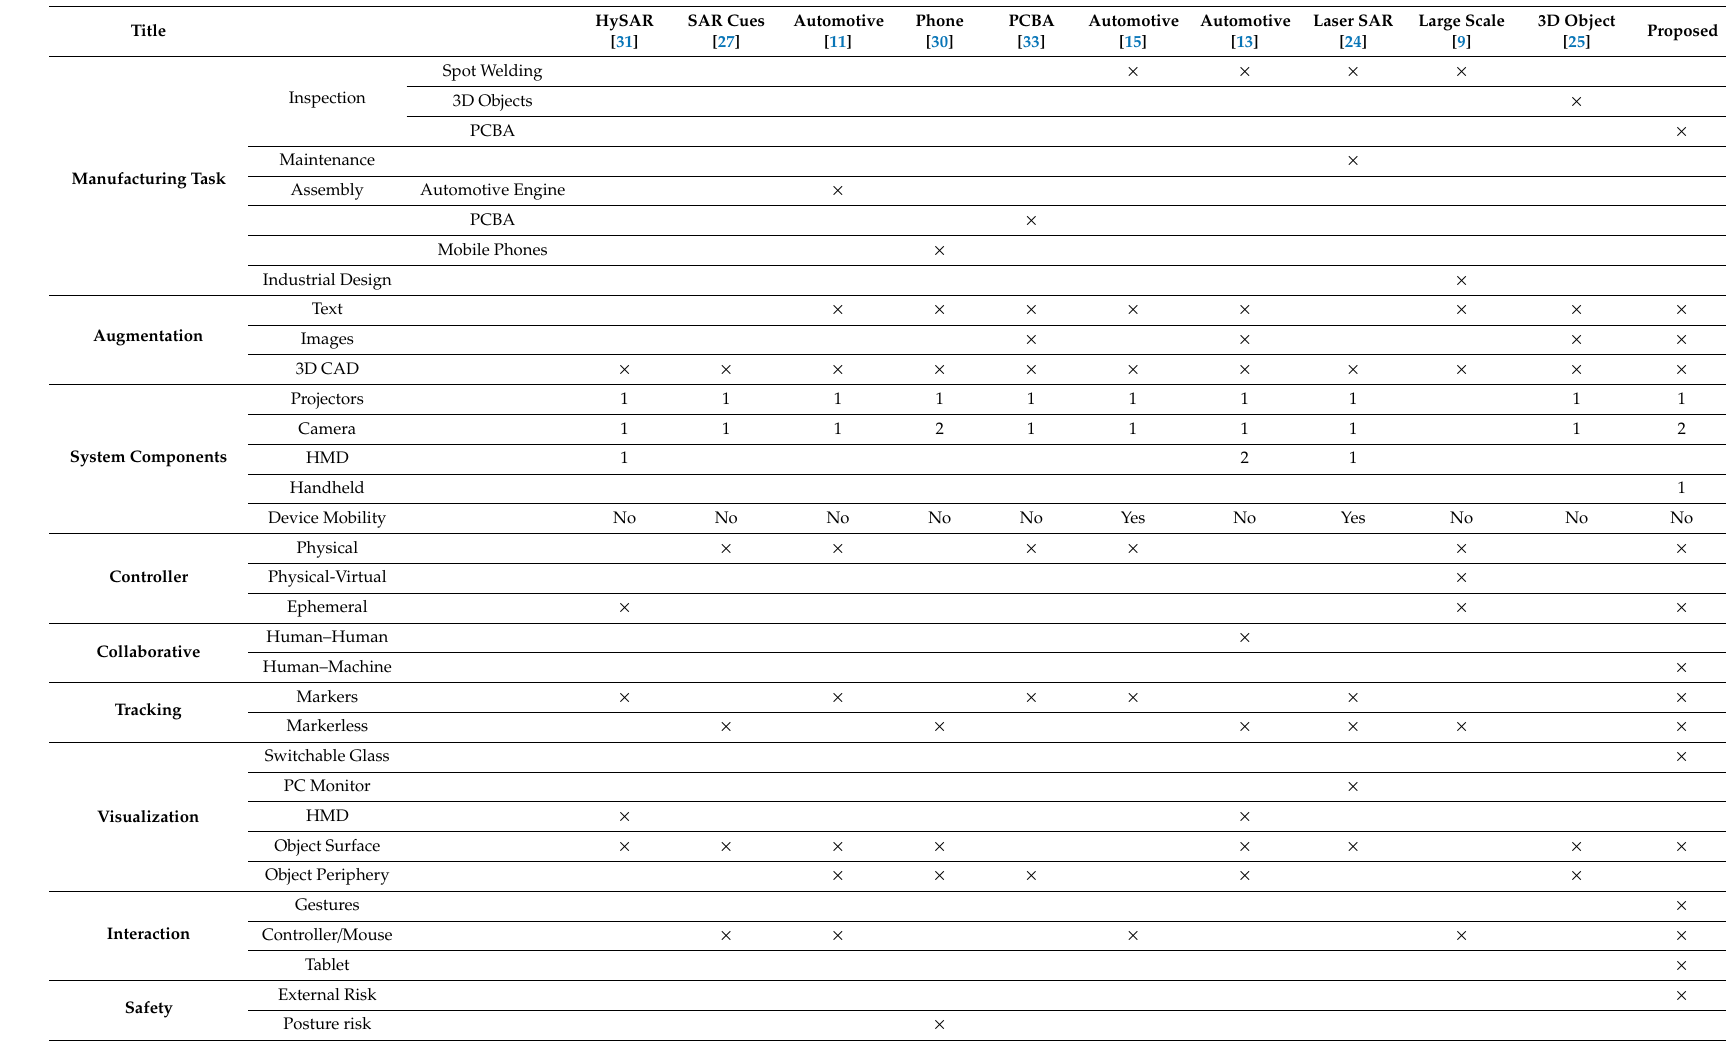
Table 1. Summary Related